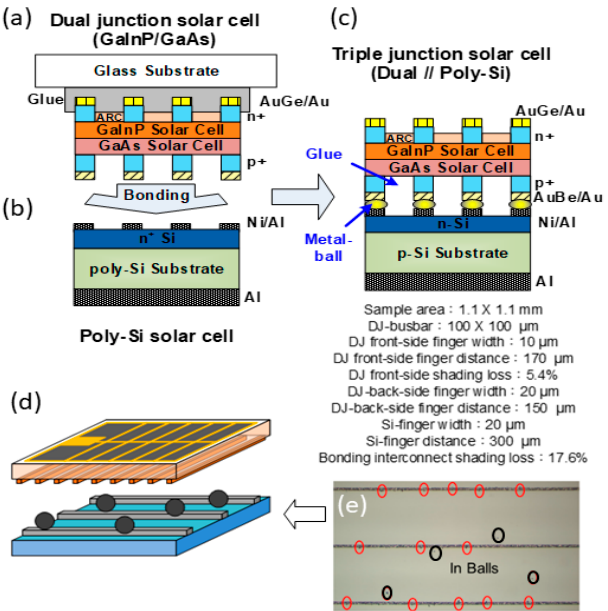
Figure 2. Schematic structure of ( a ) the GaInP/GaAs dual-junction, ( b ) poly-Si, and ( c ) GaInP/GaAs//poly-Si triple-junction solar cells. ( d ) 3D structure about the In ball bonding. ( e ) In Ball distributed on the surface of Si solar cell. Most of the In balls (red circles) assembled on the finger electrodes of the Si bottom cell observed by optical microscope. Partial In balls (blue circles) located on the Si surface.